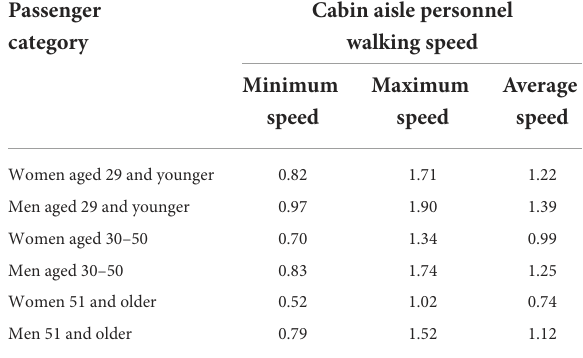
TABLE 8 The walking speed of different groups of people in the aisle when the cabin is tilted